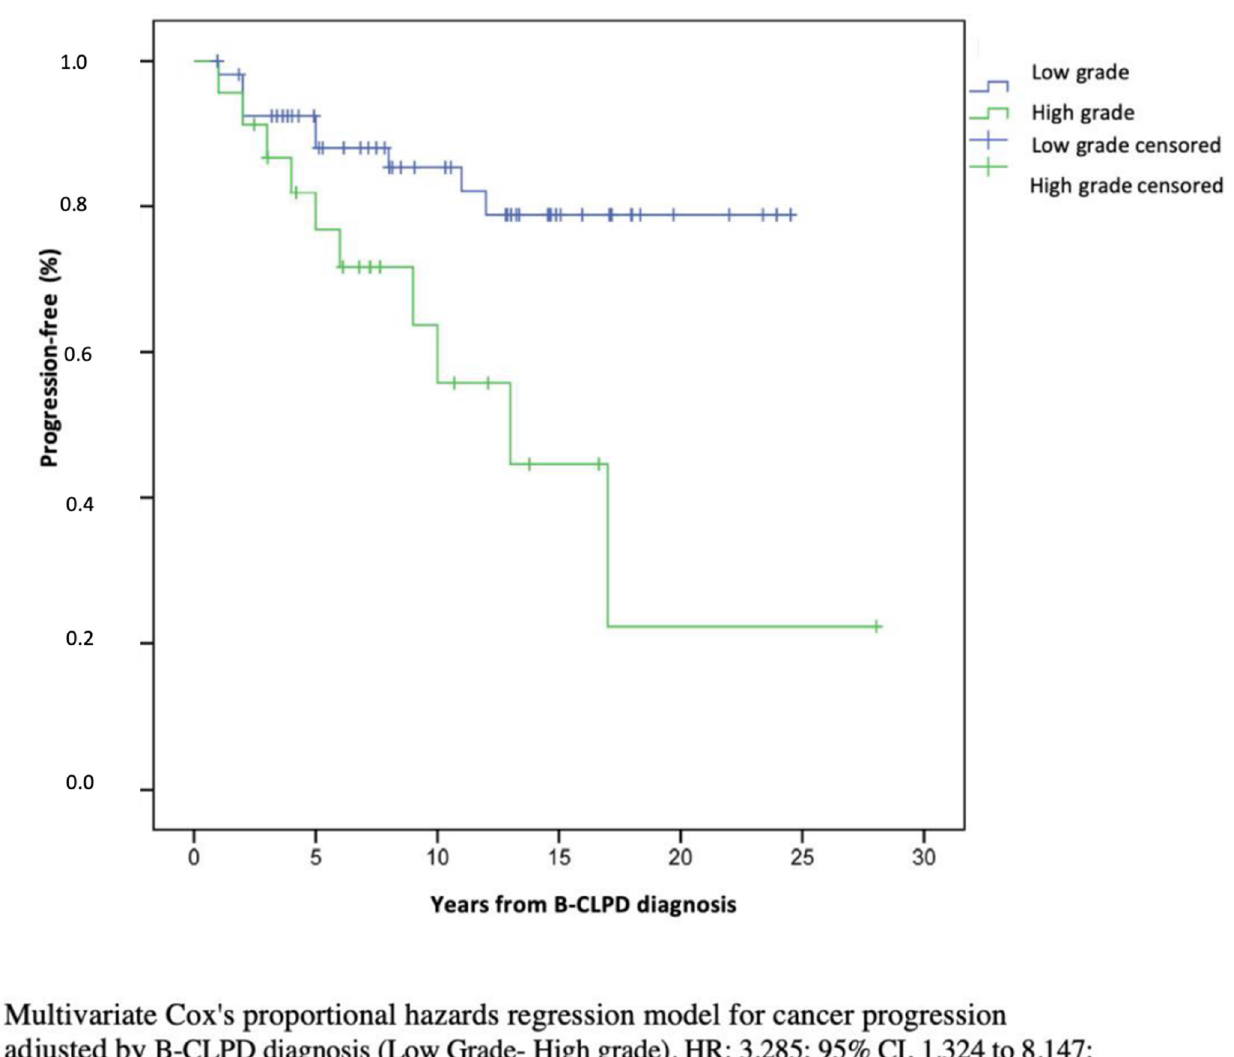
Figure 3. Multivariate Cox’s proportional hazards regression model for cancer progression adjusted by clinical stage (low grade/high grade).